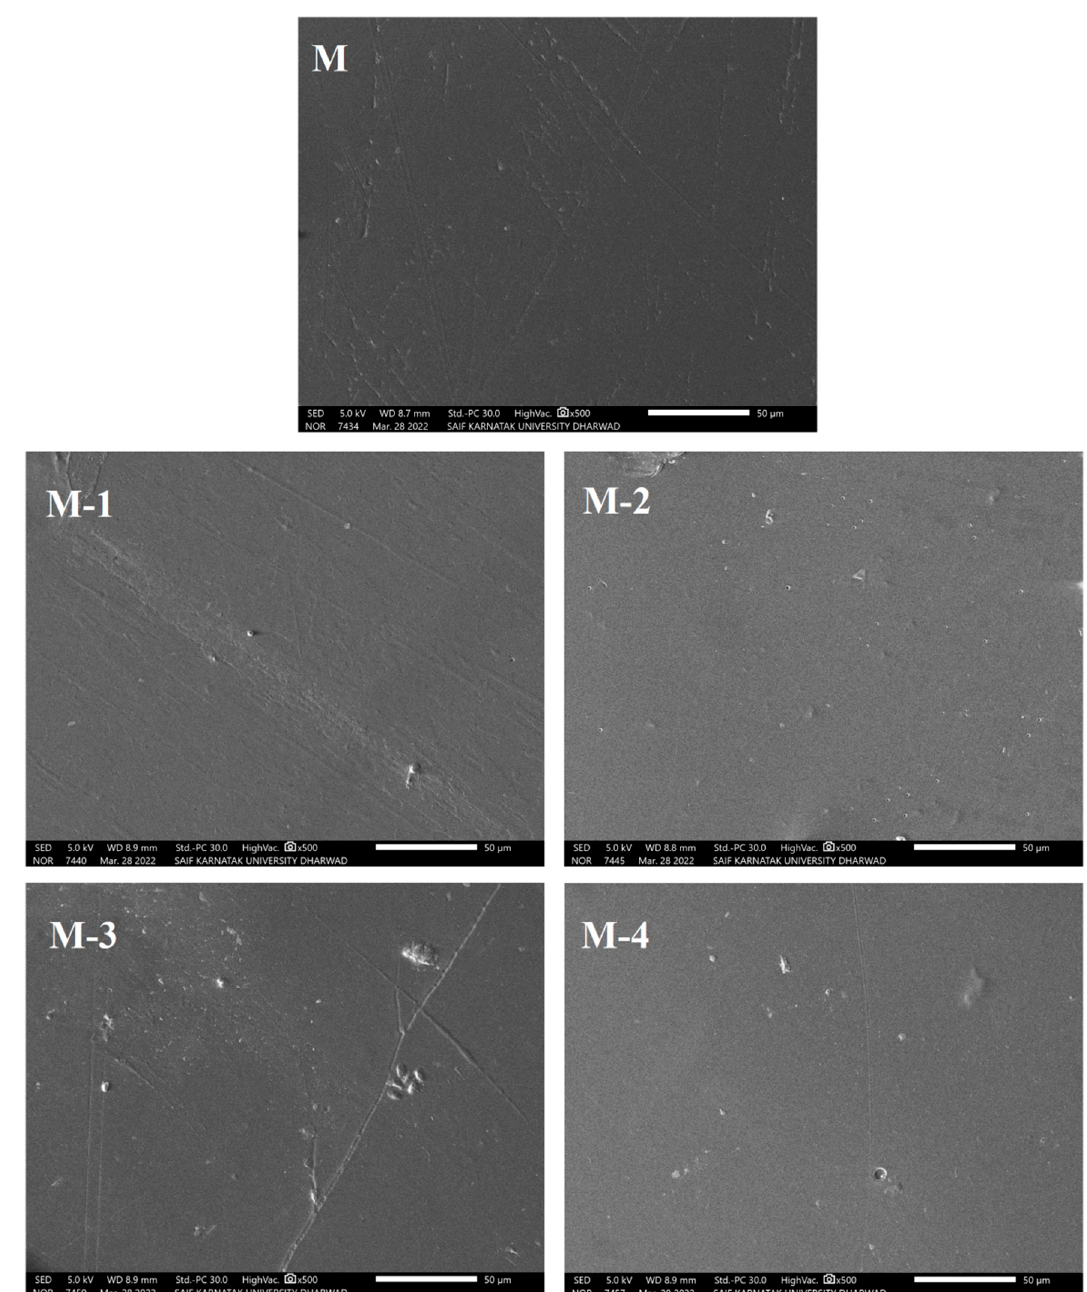
Figure 4. SEM micrographs of NaCMC and its Ge-incorporated PECM membranes; ( M ) 0